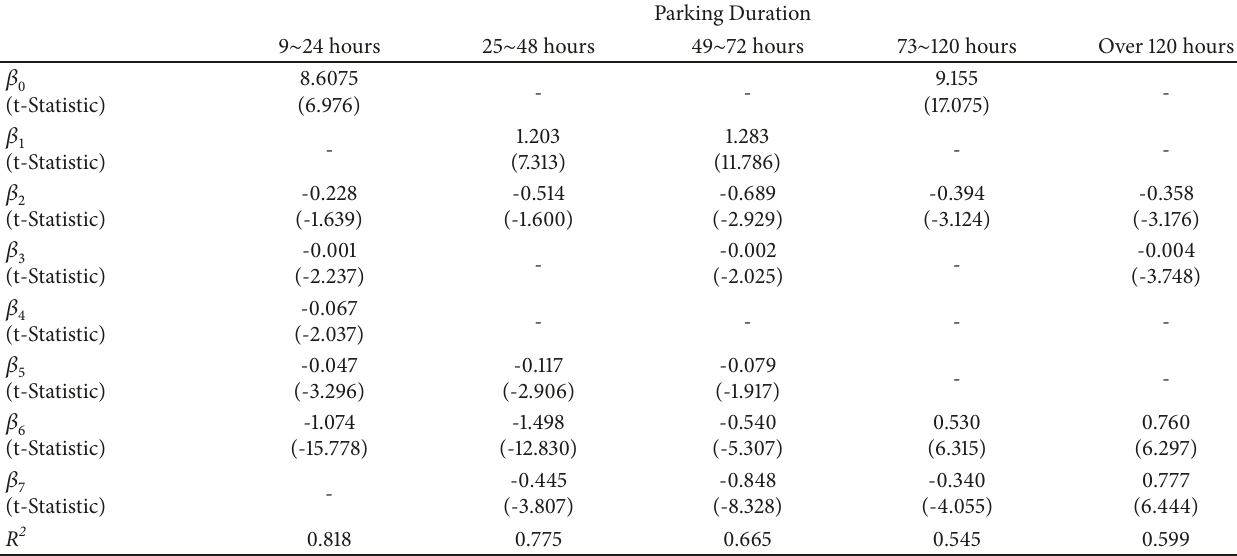
Table 6: Elasticity results for parking lot users with different duration